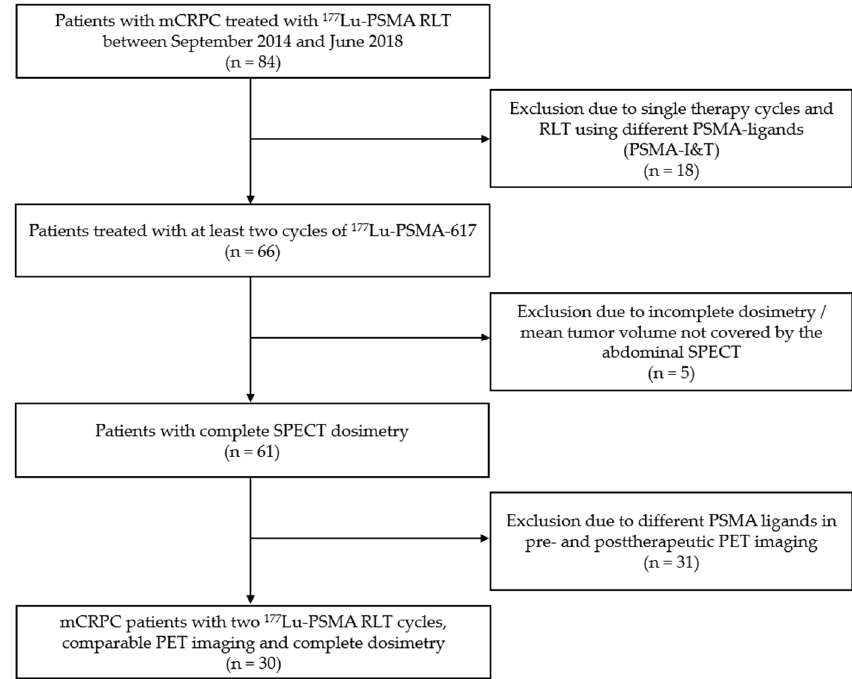
Figure 1. Flowchart with detailed information on patient selection.